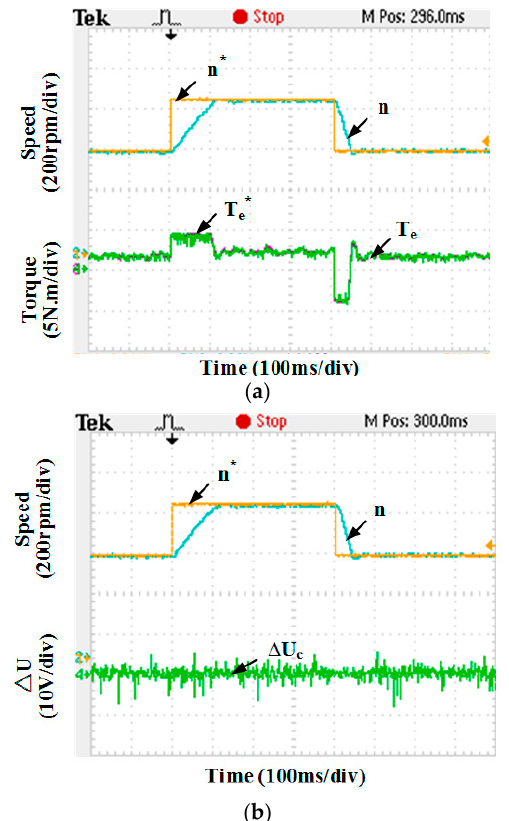
Figure 14. Dynamic response of speed waveform, torque response, and dc-link midpoint voltage deviation at the phase-change angle α of 6.5°: ( a ) speed/torque response; ( b ) speed and dc-link midpoint voltage deviation.